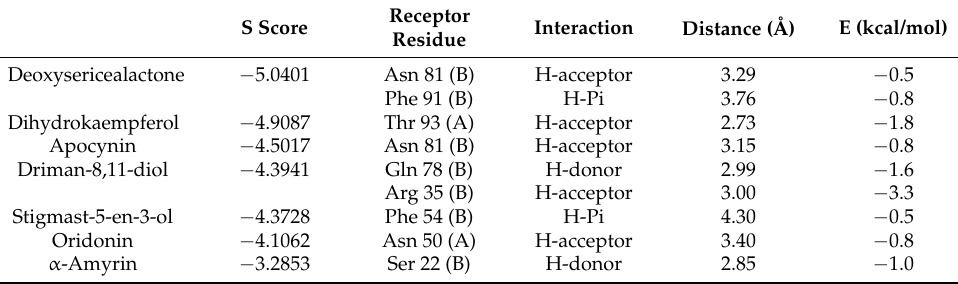
Table 3. Results of the docking studies against